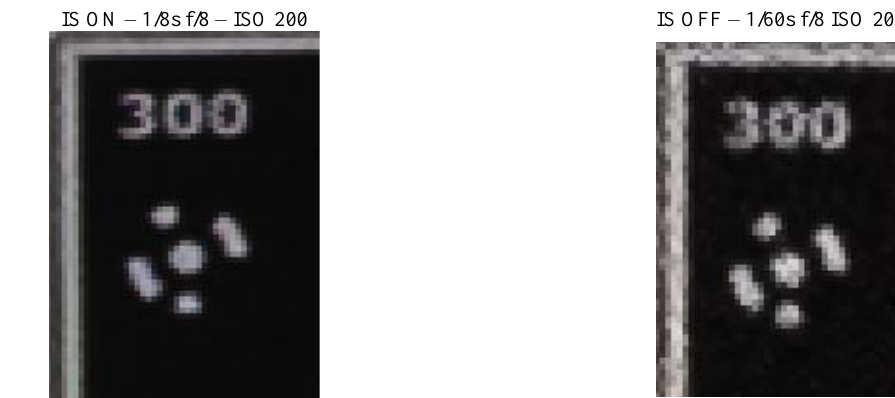
Figure 3: Comparison between meshes from the INDIGO dataset. The left column shows a detail of the mesh obtained from the images with the IS on; the right column displays the same detail from the images with IS off. A significant improvement (less noise, lower uncertainty and more details) can easily be observed in the mesh produced from the images with IS off.